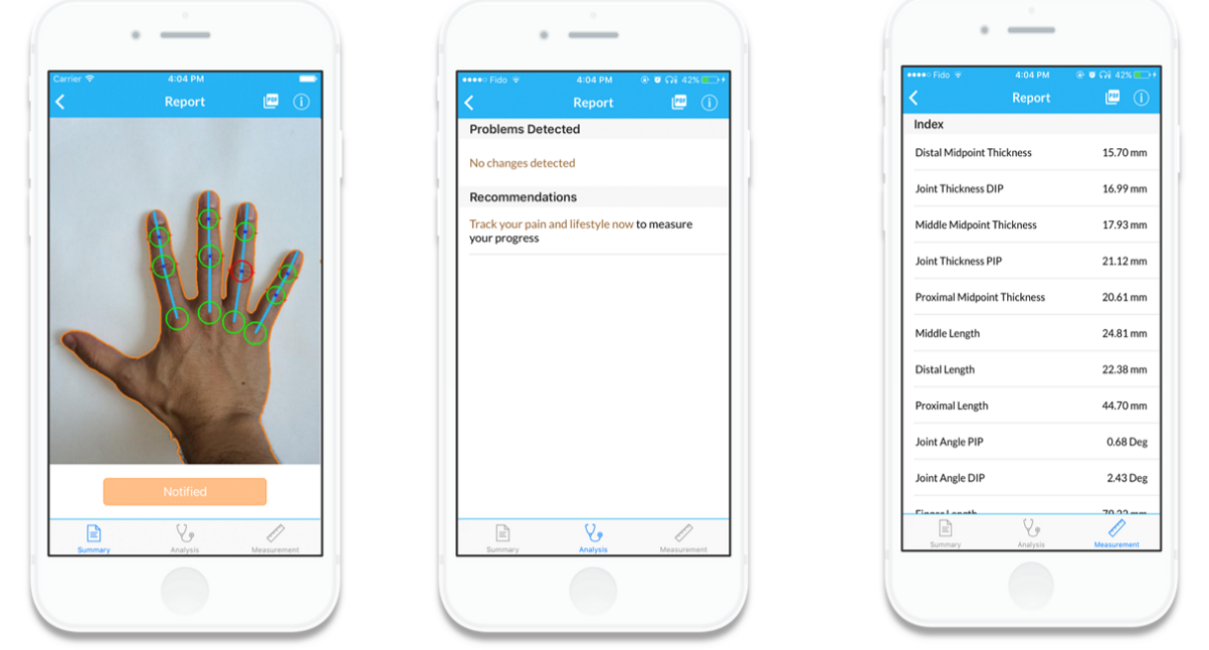
Figure 6. Output report including analyzed hand image, changes since last image, recommendations, and measurements of anatomical features of